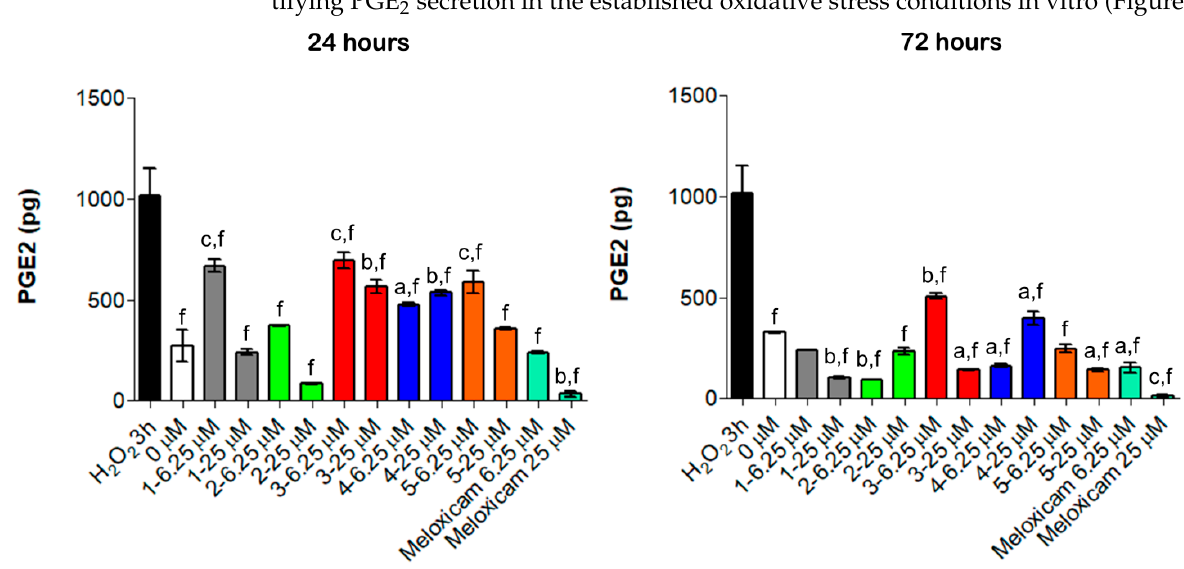
Figure 6. PGE 2 secretion from H 2 O 2 -pre-incubated human primary tendon-derived cells in the presence of increasing concentrations of CORMs after 24 and 72 h. Cells were pre-incubated with H 2 O 2 100 µ M for 3 h. 0 µ M = cells pre-incubated with H 2 O 2 and treated with DMSO 0.1%. The amount of PGE 2 secreted (pg/mL) was normalized on cell metabolic activity data, resulting in the PGE 2 secreted from each sample (total picograms). a = p < 0.01; b = p < 0.001; c = p < 0.0001 between cells treated with CORMs and the control sample. f = p < 0.0001 between cells exposed to CORMs and cells pre-treated with H 2 O 2 for 3 h.